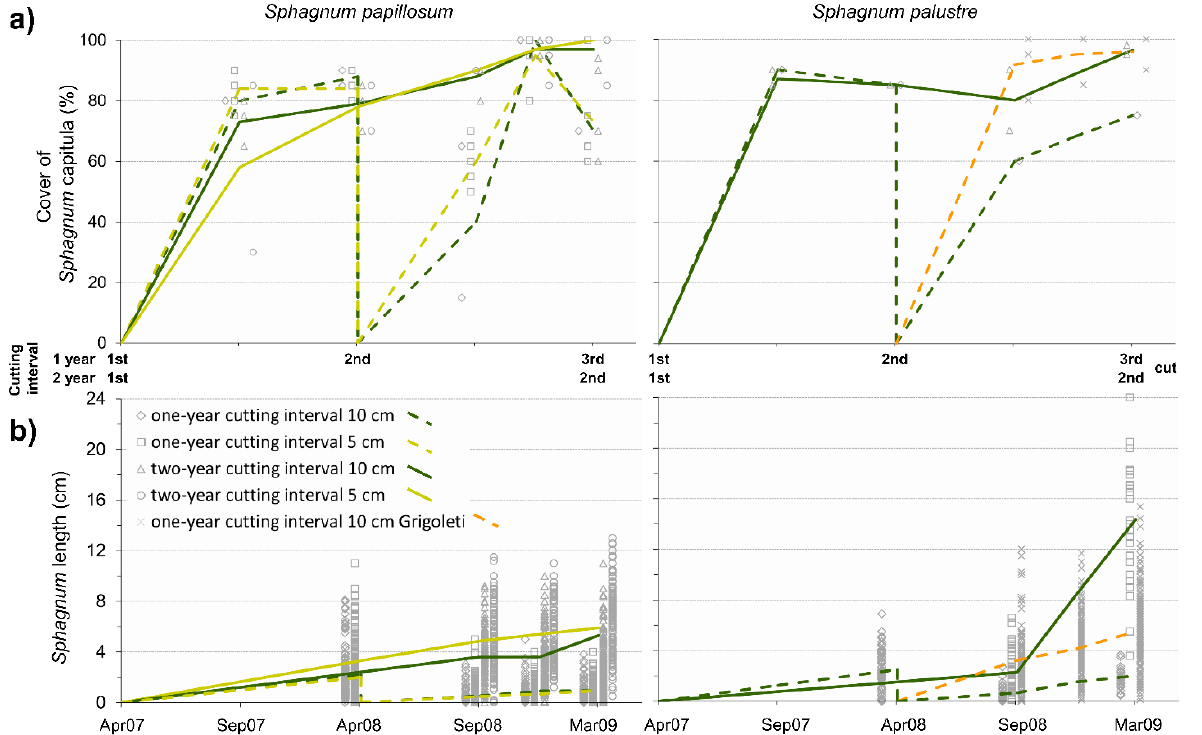
Figure 3. Development of regrown capitula cover (a) and length increase (b) after cutting of S. papillosum and S. palustre at different initial cutting depths (5, 10 cm) and intervals (1, 2 years) on the plots (cover) and sampling squares (length) at Ispani 1 and Grigoleti (Georgia). Each column of grey symbols represents the measurements on one treatment and date, and the lines represent means for different treatments (see